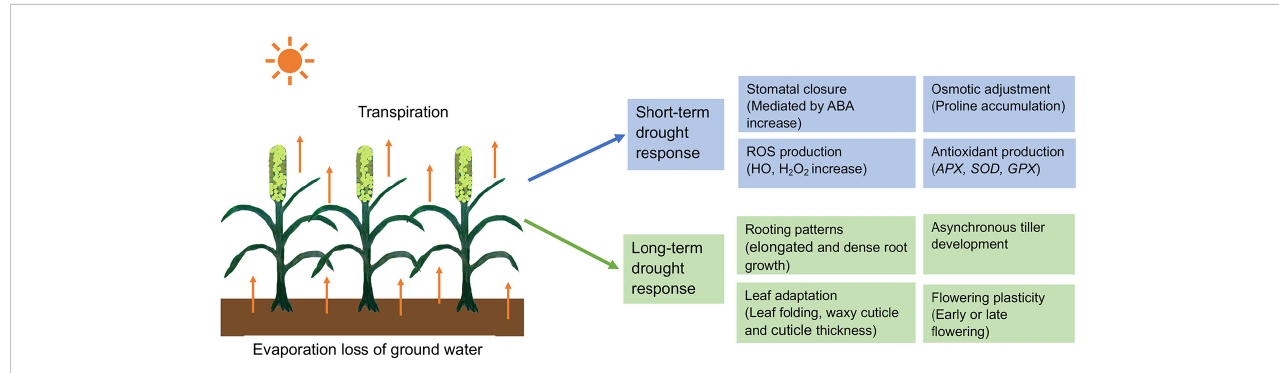
FIGURE 1 Short-term and long-term responses of pearl millet to adapt drought stress. ROS, Reactive oxygen species; HO, Hydroxyl radical; H 2 O 2 , Hydrogen peroxide; APX, Ascorbate peroxide; GPX, Glutathione peroxidase; SOD, Superoxide dismutase